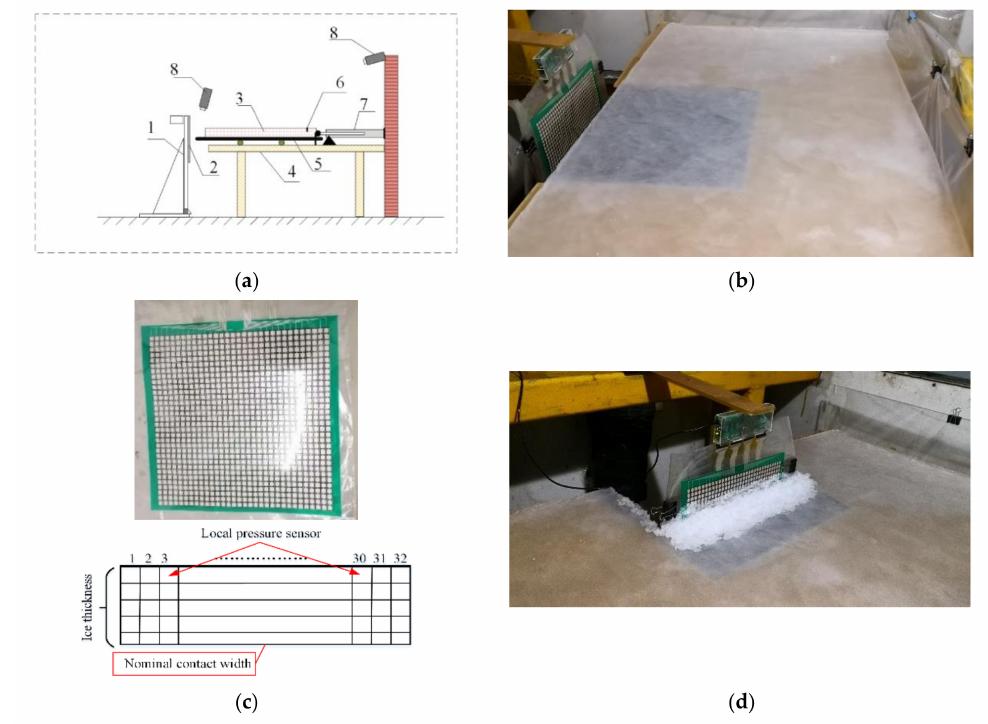
Figure 3. Indentation test device and schematic. ( a ) device schematic; ( b ) device and frozen ice sheet; ( c ) thin-film pressure transducer; ( d ) test